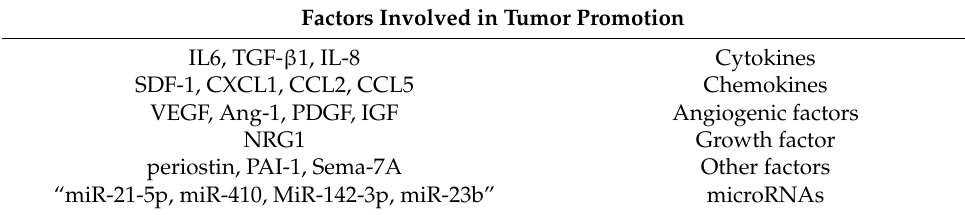
Table 1. The role of tumor-promoting